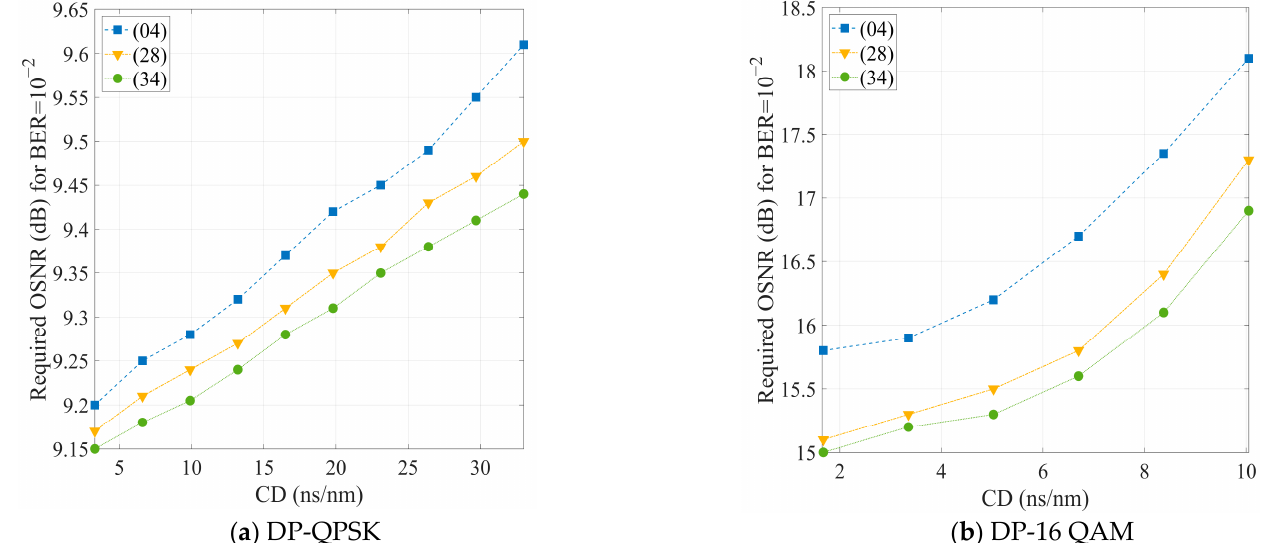
Figure 2. The OSNR penalty performance of the DP-QPSK and DP-16 QAM data. ( a ) The signal modulation format is DP-QPSK; ( b ) The signal modulation format is DP-16 QAM.